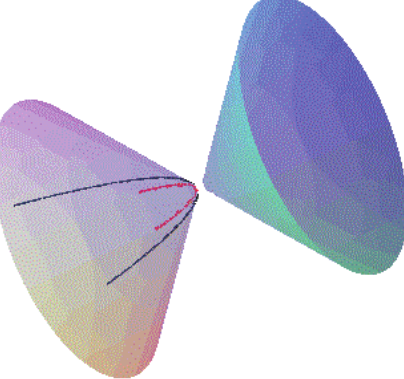
Figure 4: The 𝛼𝑇𝜉 -pseudohyperbolical Smarandache curve 𝛽 and the curve 𝛼 on 𝐻 2 0 (1)